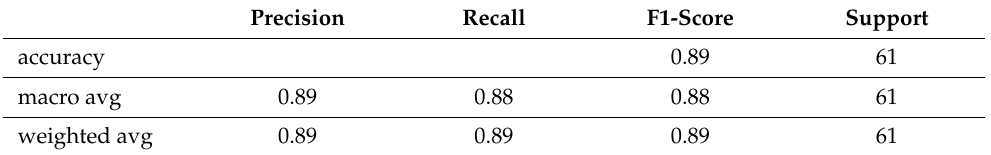
Table 2. Classification Report.